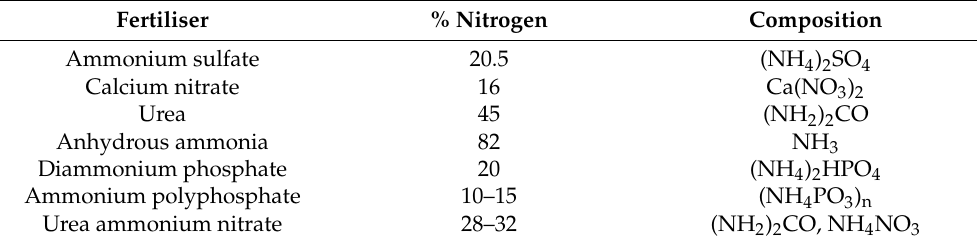
Table 1. Some commonly used nitrogen fertilizers